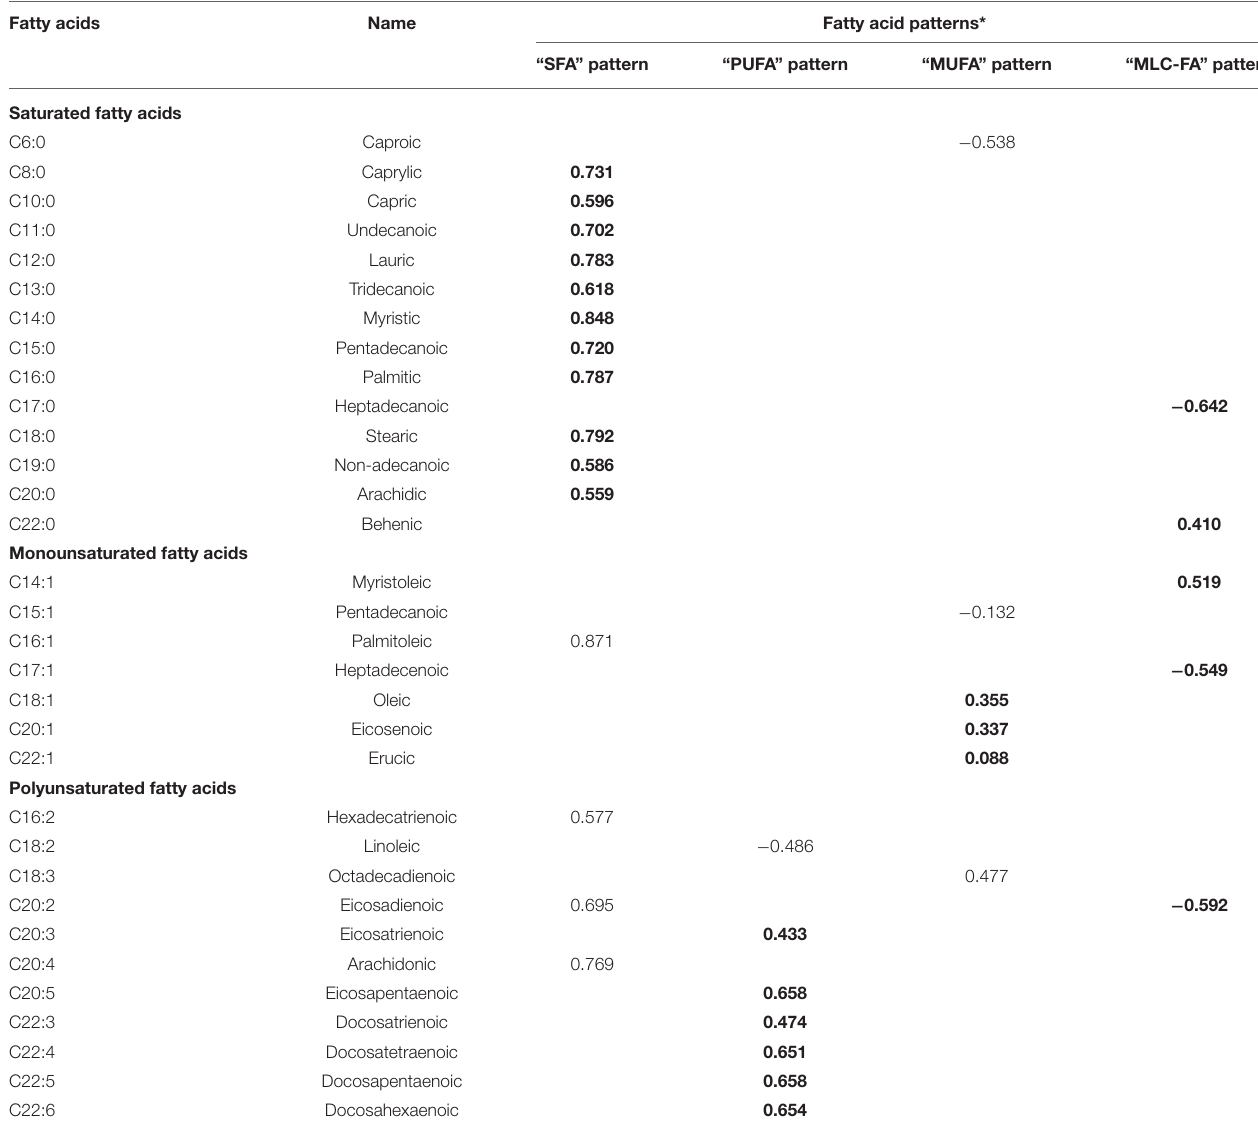
TABLE 2 | Factor-loading matrix for four fatty acid patterns. Fatty acids Name Fatty acid patterns* “SFA” pattern “PUFA” pattern “MUFA” pattern “MLC-FA”